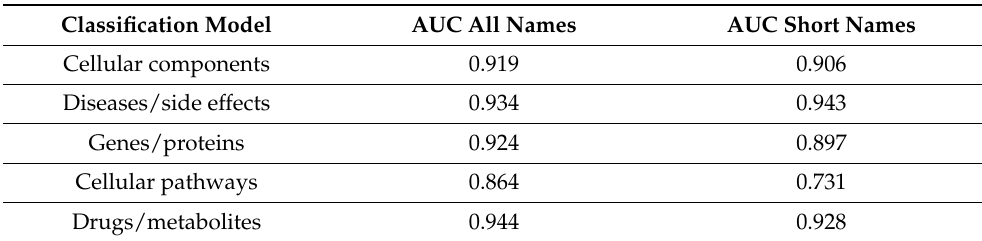
Table 2. AUC values for each model, calculated using the existing gold standards for objects of any length, and for short objects only.